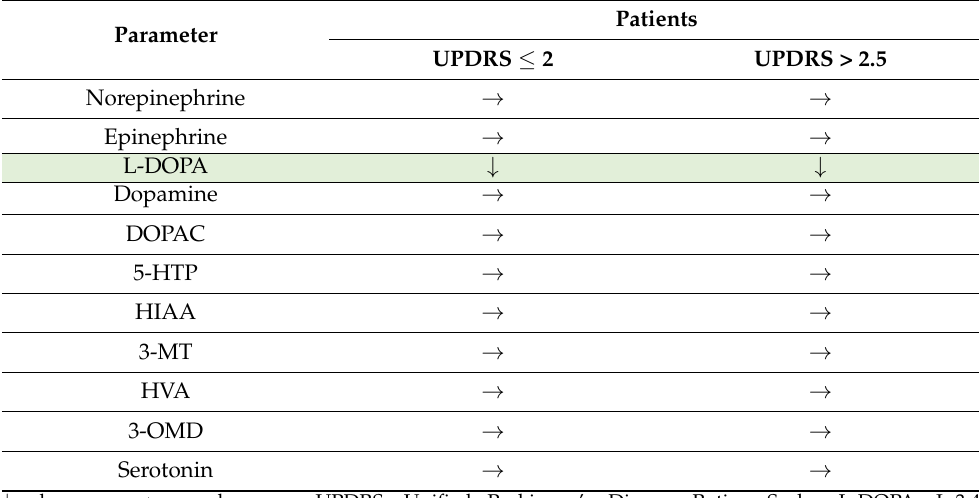
Table 3. Change in the concentration of monoamines and metabolites in patients with the risk of developing PD compared with